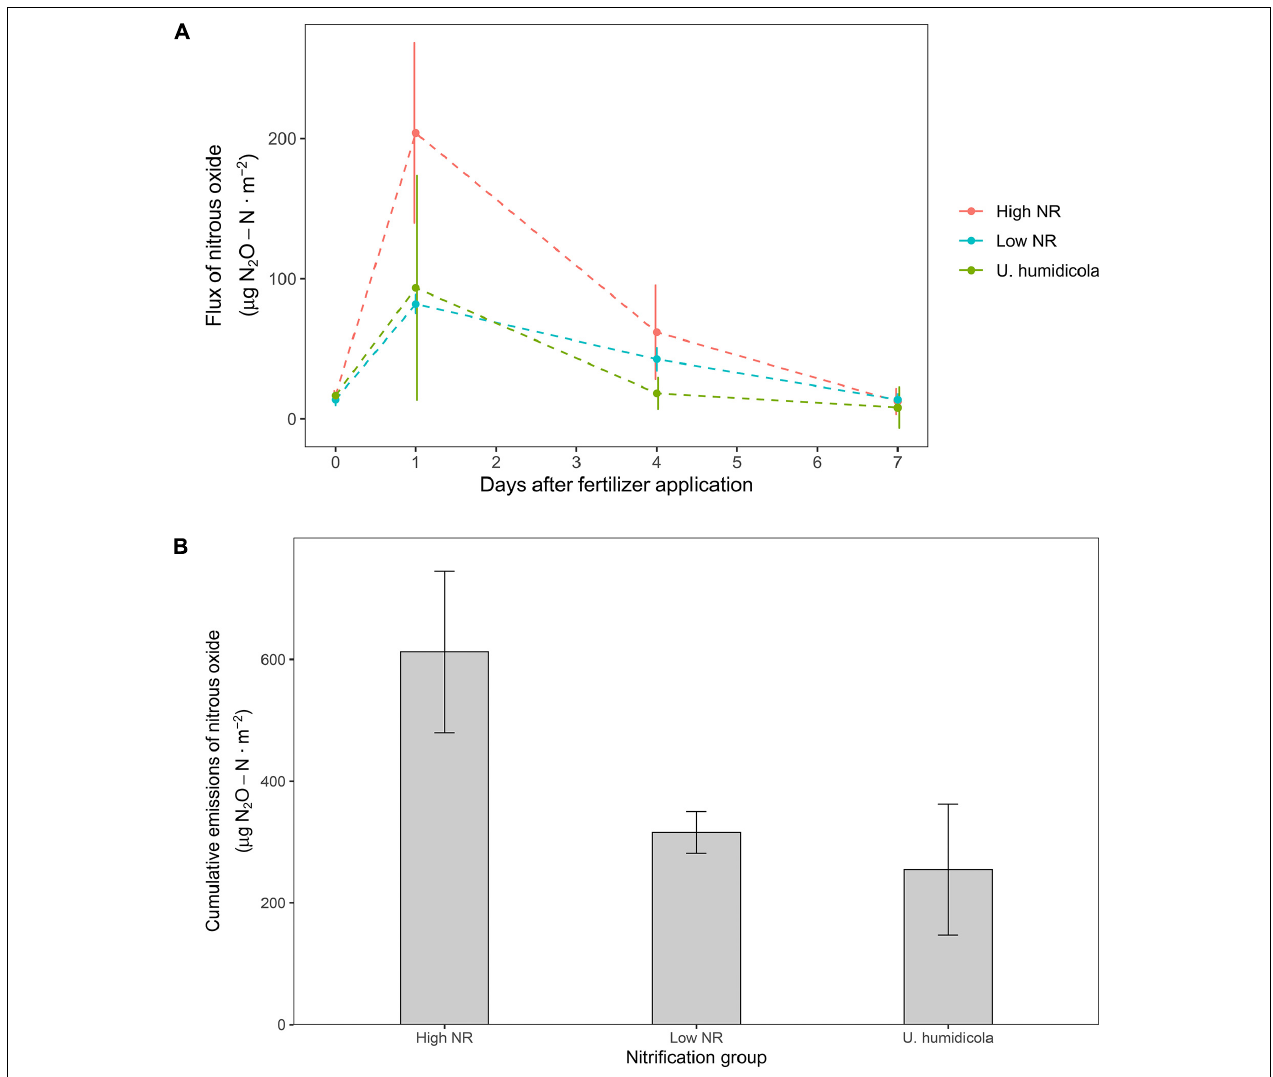
FIGURE 3 | (A) Daily flux of N 2 O after fertilizer application in accessions of M. maximus of different nitrification rates and the high BNI control U. humidicola . (B) Cumulative emissions of N 2 O after the whole measurement period of seven